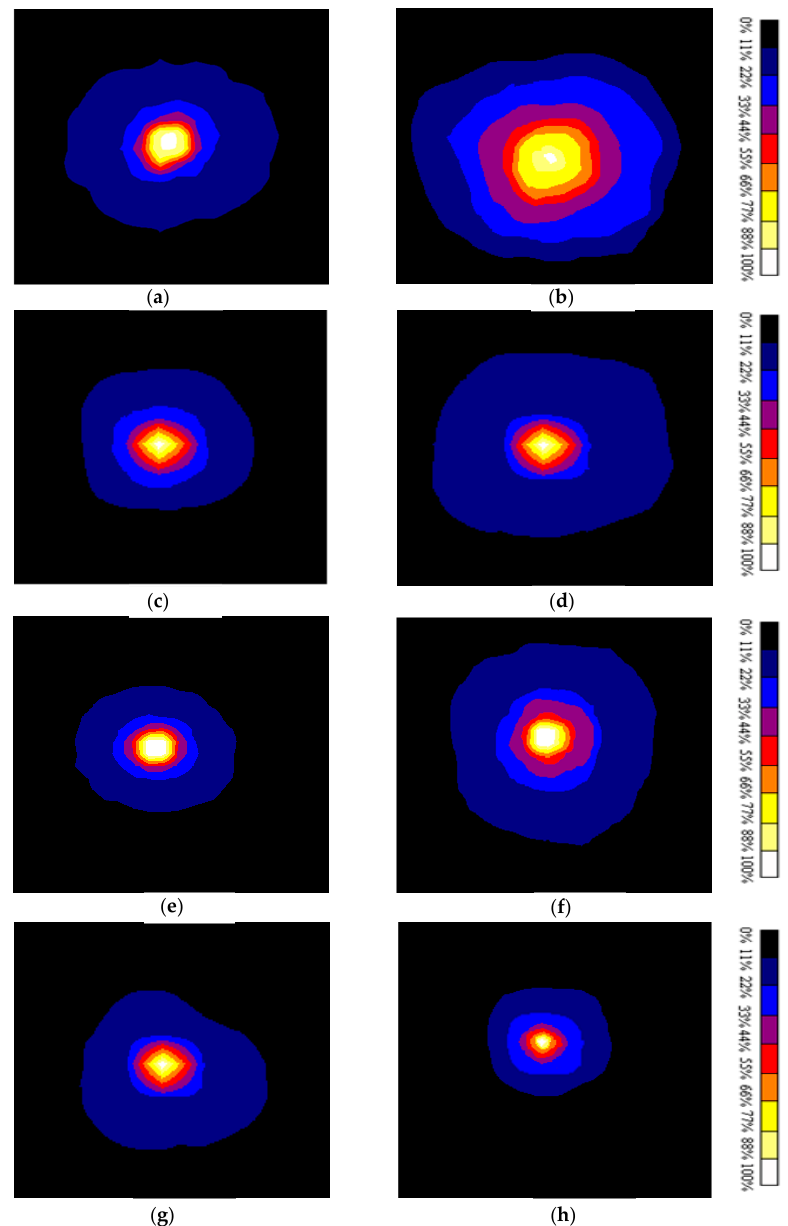
Figure 3. Processed backscattering images. ( a , b ) Granny Smith with and without skin at 633 nm; ( c , d ) Granny Smith with and without skin at 852 nm; ( e , f ) Golden Delicious with and without skin at 763 nm; and ( g , h ) Royal Gala with and without skin at 784 nm.